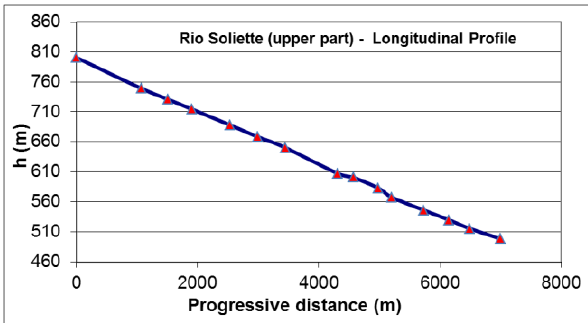
Figure 8. Longitudinal profile of the upper part of the River Soliette